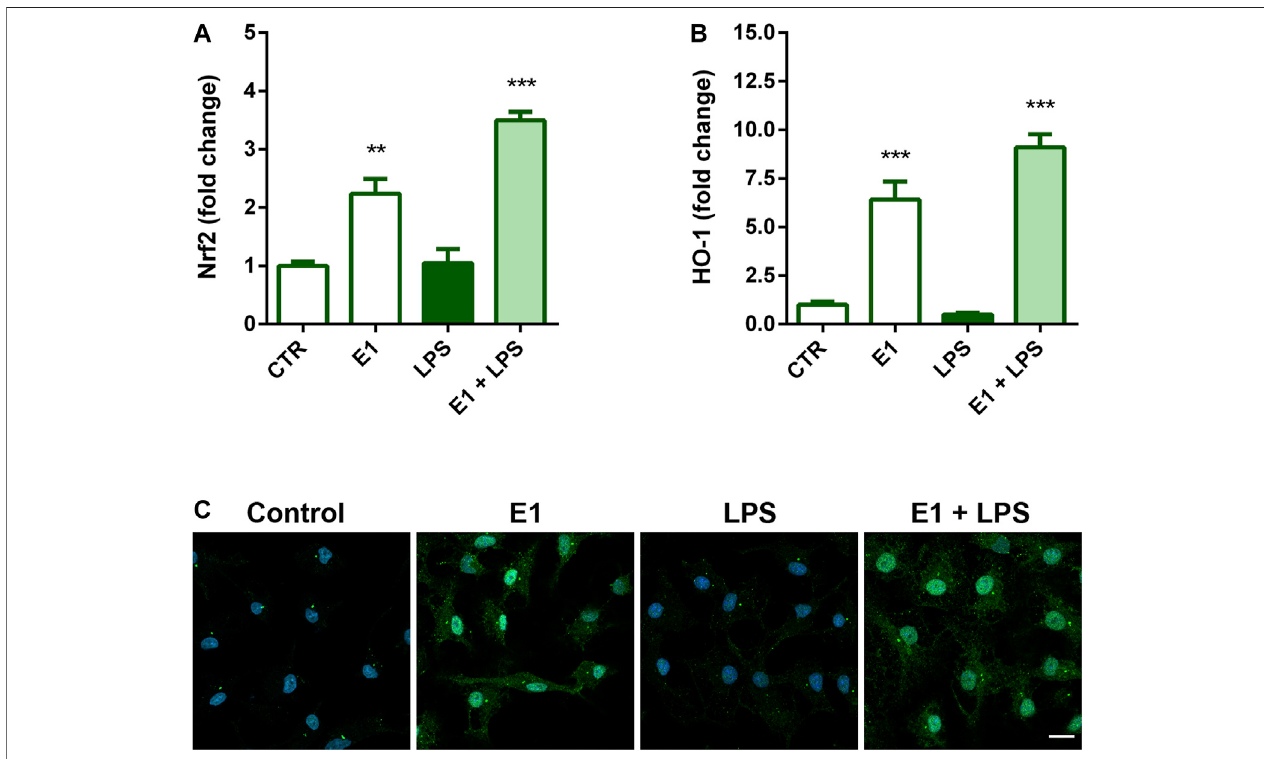
FIGURE 6 | Effect of Spirulina extract on Nrf2 signaling in unstimulated and LPS-stimulated microglia. Cells were cultured for 24 h in 10% serum-containing medium,whichwasreplacedwithserum-freemediumbeforepre-treatmentwith100 μ g/mlE1for1 hfollowedbystimulationwith100 ng/mlLPS. (A) Nrf2and (B) HO-1 mRNA levels were quanti fi ed by real-time PCR. Dataare presented as means ± SEM( n (cid:1) 3 in triplicate). ** p < 0.01 and *** p < 0.001 compared to control cells. One-way ANOVA followed by Sidak ’ s multiple comparison test. (C) Microglia were stained with anti-Nrf2 antibody (green) and nuclei with DAPI (blue). Experiments were performed three times and representative immuno fl uorescence images are shown. Scale bar, 10 μ